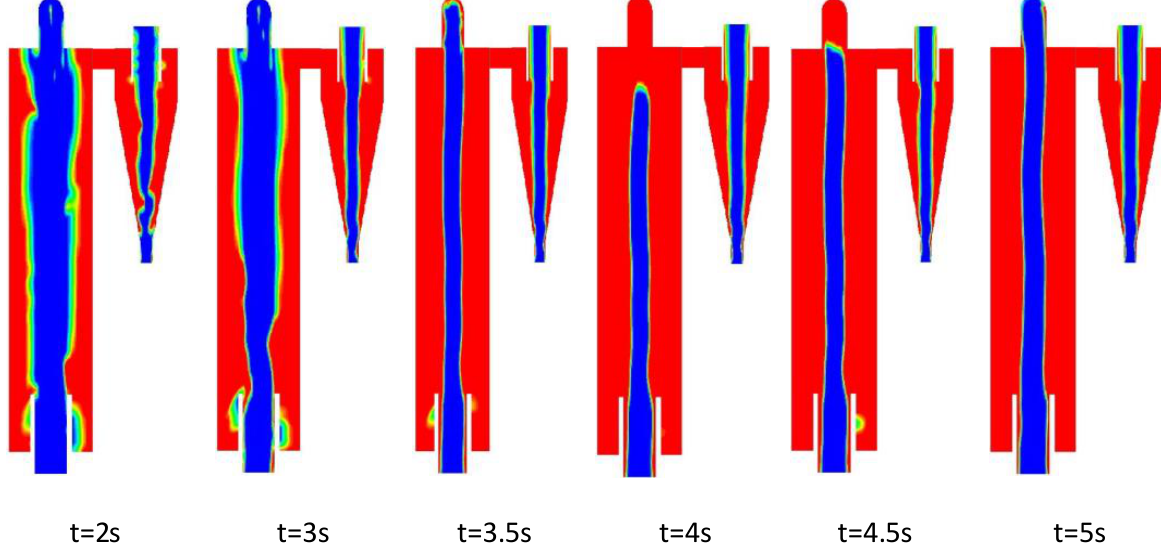
Figure 5. Illustration of the formation of air core in the hydrocyclone sand washer.